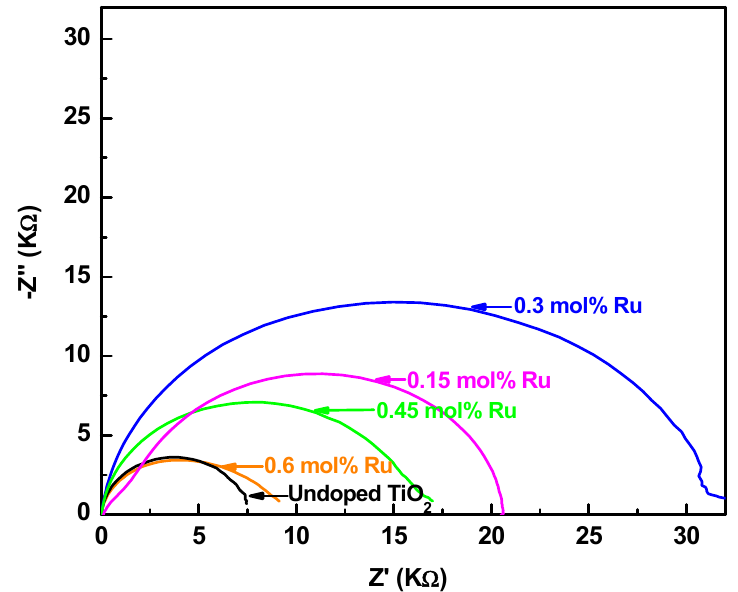
Figure 7. Nyquist plot of DSSCs with 0.15, 0.3, 0.45, 0.6 mol% Ru-doped TiO 2 photoanodes and the control cell in dark.